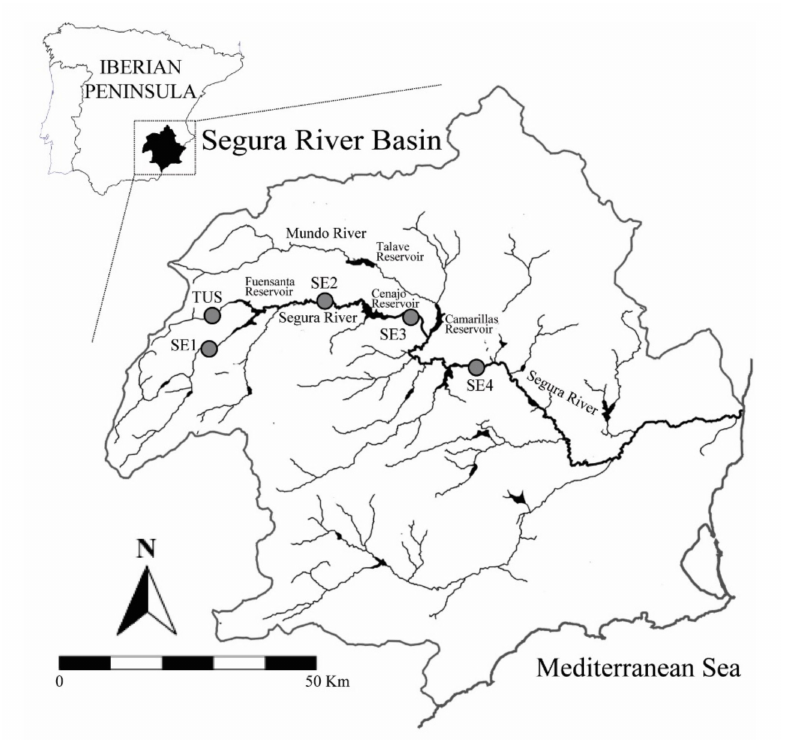
Figure 1. Sampling sites location for Gobio lozanoi in the Segura River basin at south-eastern Iberian Peninsula,